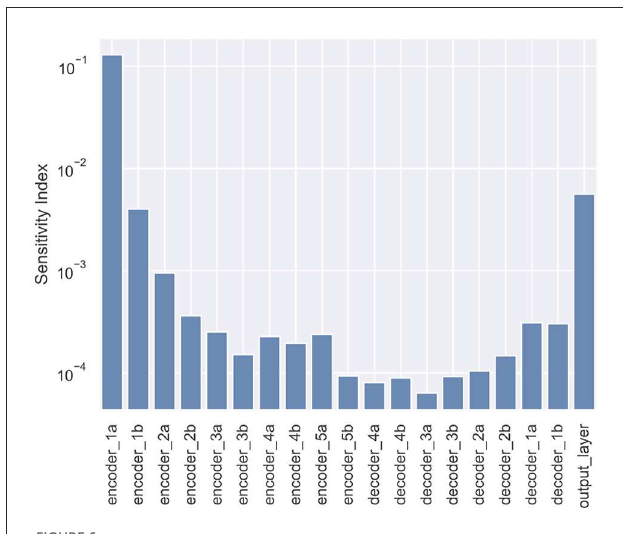
FIGURE6 Sensitivity Index (SI) for all layers in the U-Net used for tumor segmentation. The layer encoder_1a has the highest SI and is selected for